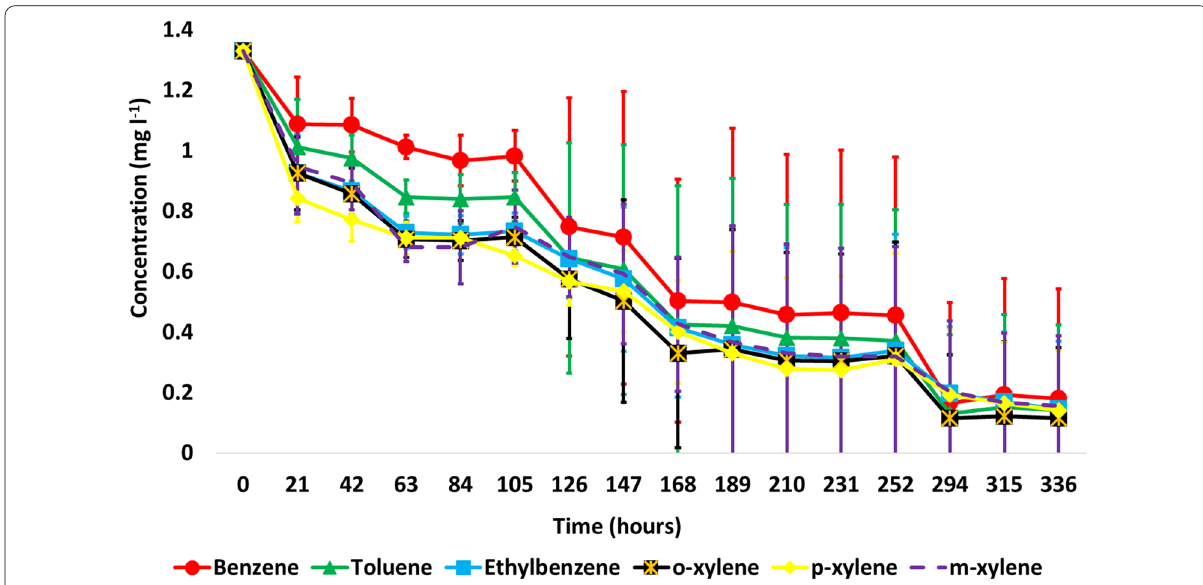
(Additional file 1: Table S4). Five catechol 2,3-dioxy- tional file 1: Table S5).